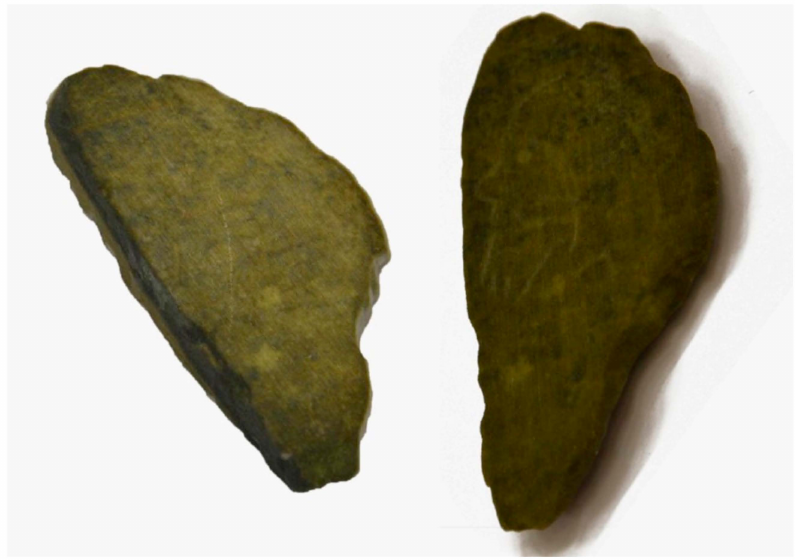
Figure 7. Comparison between the colored 3D replica and the “augmented”